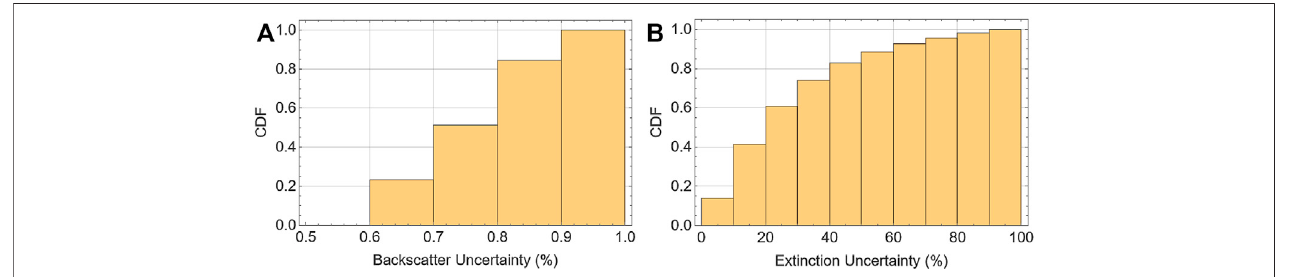
FIGURE 7 | Cumulative Distribution Function for the uncertainty in PBL aerosol backscatter coef fi cient (A) and aerosol extinction (B) simulations.